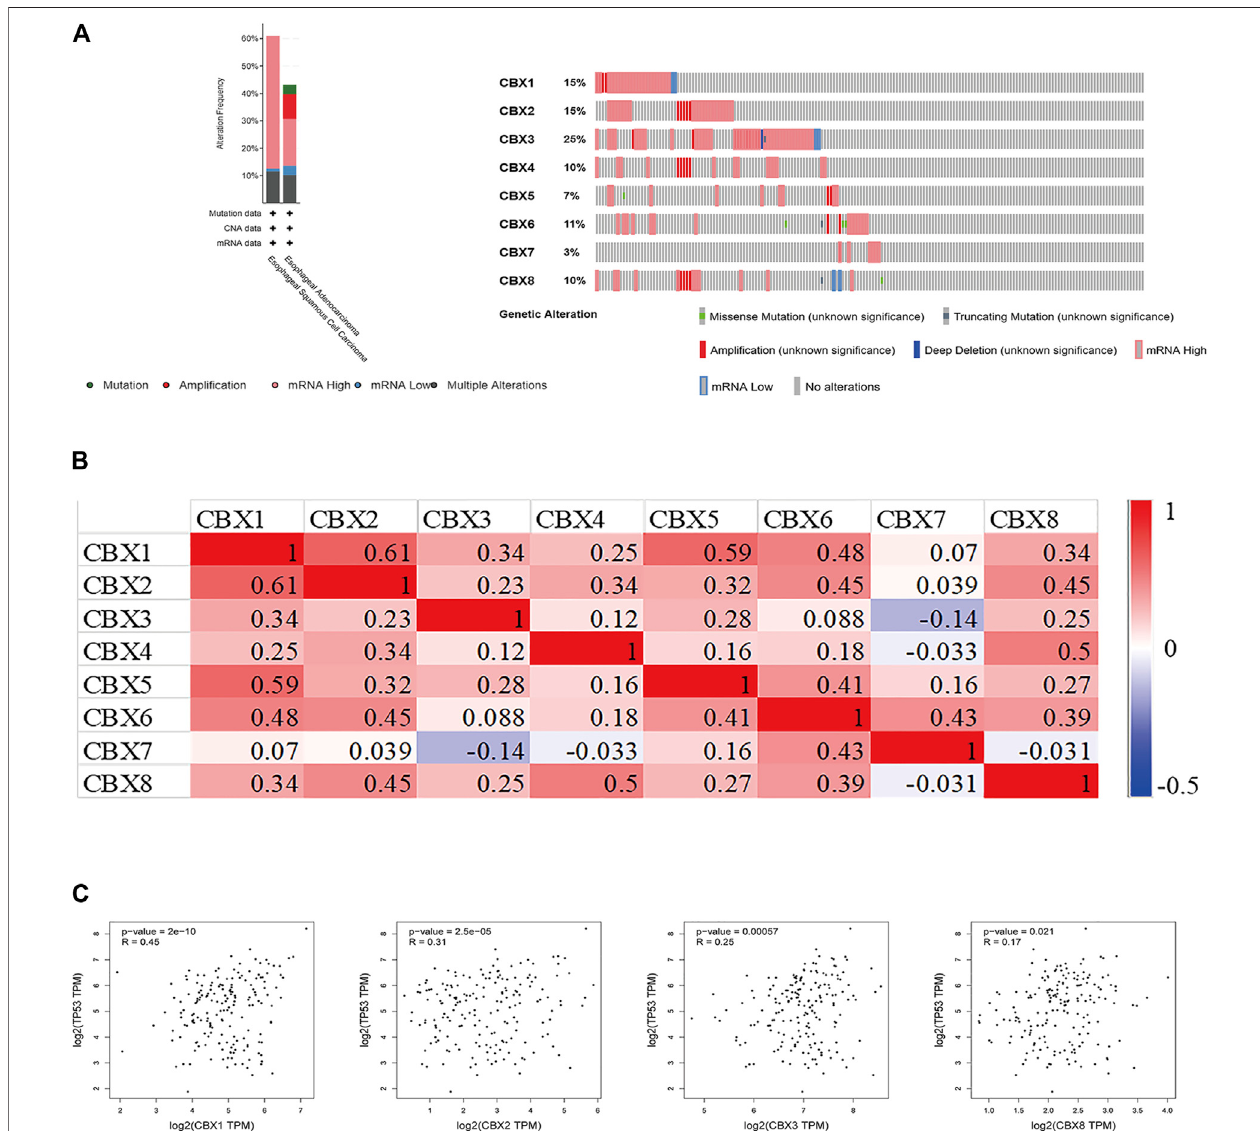
FIGURE 5 | (A) Summary of alterations in different expressed CBXs in ESCA. CBXs were altered in 96 samples of 183 patients with ESCA, accounting for 52% (cBioPortal). (B) Correlation between different CBXs in ESCA(GEPIA). (C) Correlation between CBX family members and TP53 expression (GEPIA). The p value was set at 0.05